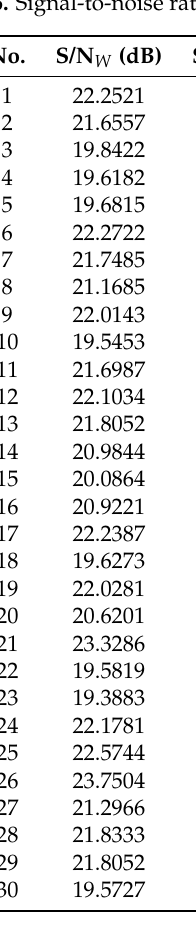
Table 6. Signal-to-noise ratios (SNRs) of response targets.